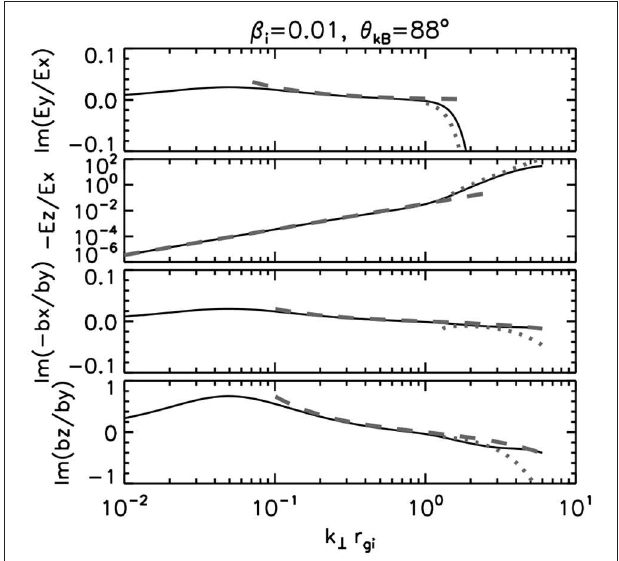
FIGURE 3 | Transport ratios for different values of propagation angle to the mean magnetic field. The parameter set is taken from Figure 2 . Again, Equation (22) shows that the rotation sense of the